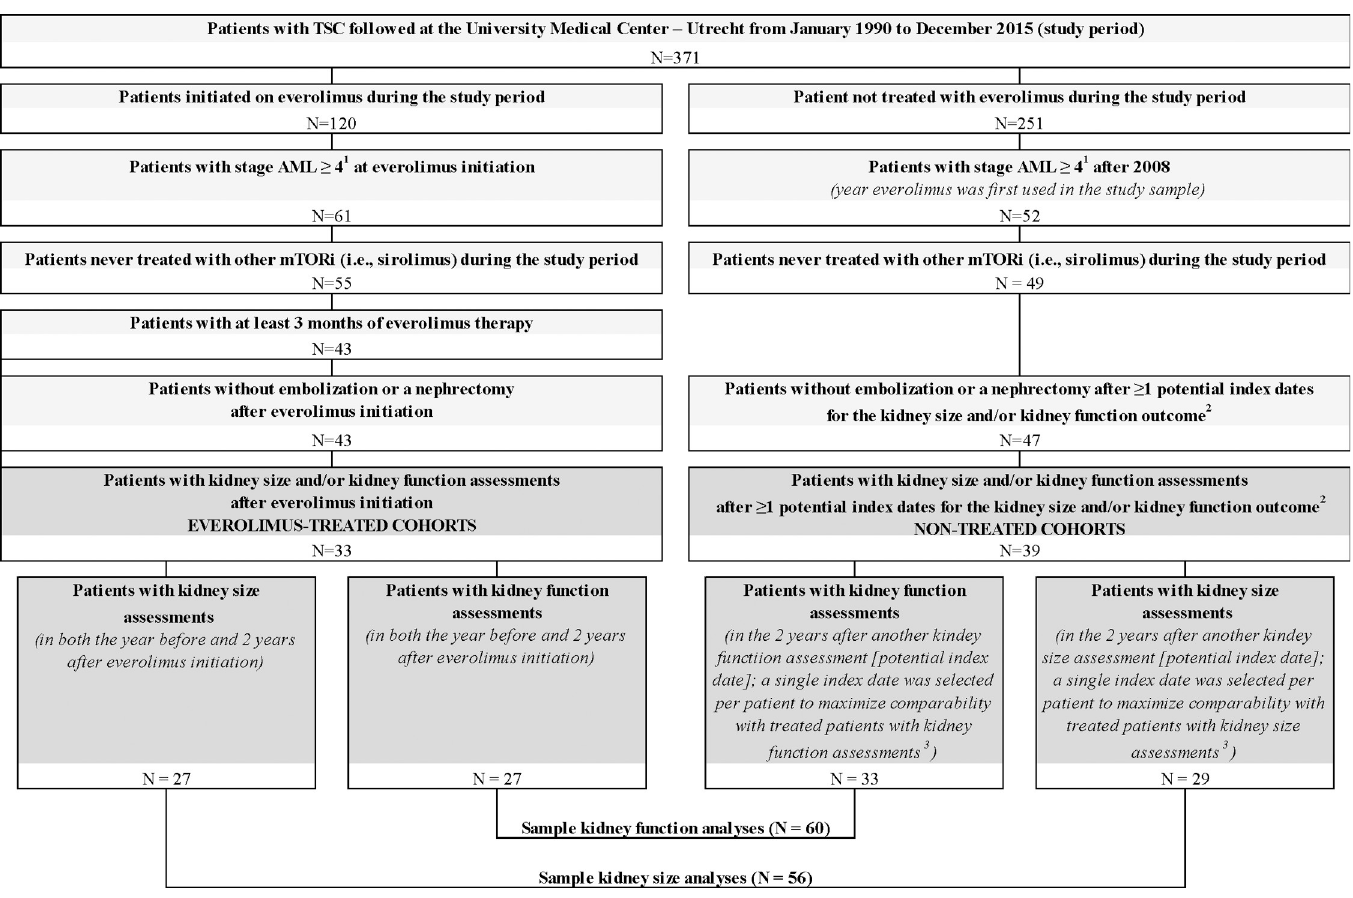
Fig 1. Patient disposition. 1 Please see Table 1 for criteria used to define rAML stage. 2 For the kidney size outcome, potential index dates were selected from days with kidney size assessments (with an MRI or CT sca); for the kidney function outcome potential index dates were selected from days with creatinine assessments. 3 For a given patient and a given outcome, if multiple potential index dates were available, a single index date was selected based on time at which the patient was the most likely to be treated with everolimus (probability of everolimus treatment was estimated from a logistic regression model including the following covariates: age at index date and eGFR and size of the largest kidney at the index